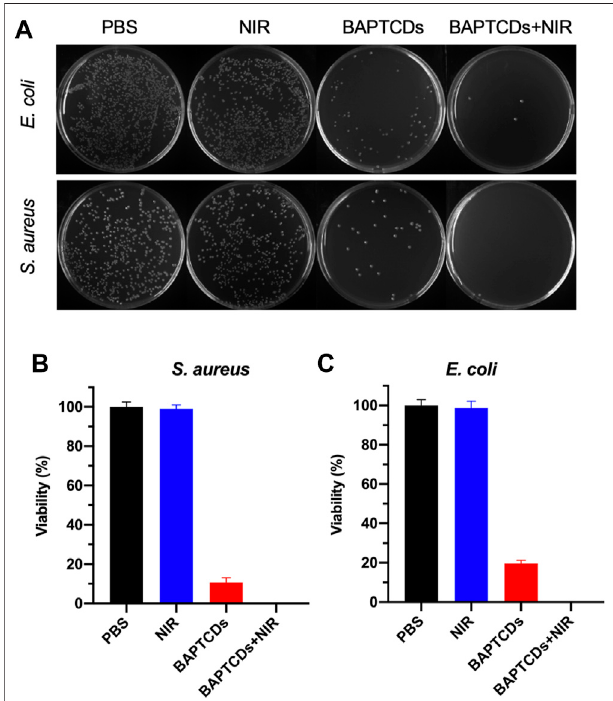
FIGURE 7 | (A) Photographic images of the colonies of E. coli ATCC 700926 and S. aureus ATCC 29213 treated by PBS, BAPTCDs, BAPTCDs withNIR(powerdensity=1.5 W/cm 2 ),andNIRonlybyastandardplatecount method. The concentration of BAPTCDs was 200 μ g/ml. Bacterial viability of E. coli ATCC 700926 (B) and S. aureus ATCC 29213 (C) were obtained by the colony-forming count method. (Error bars represent the standard deviation of at least three independent experiments.).